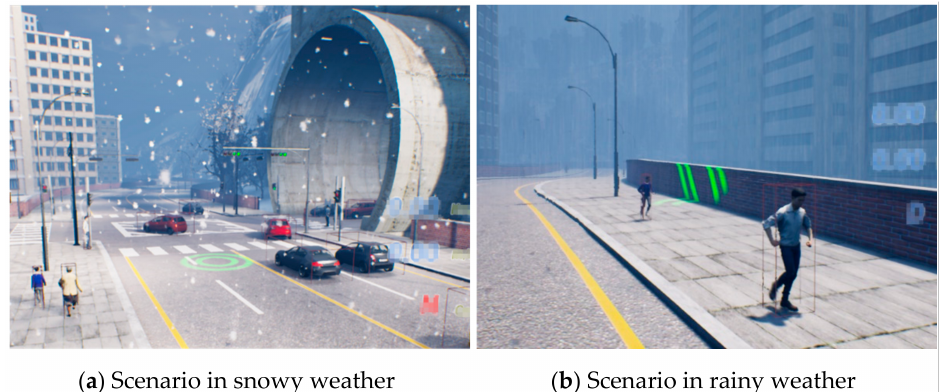
Figure 12. Scenarios in different